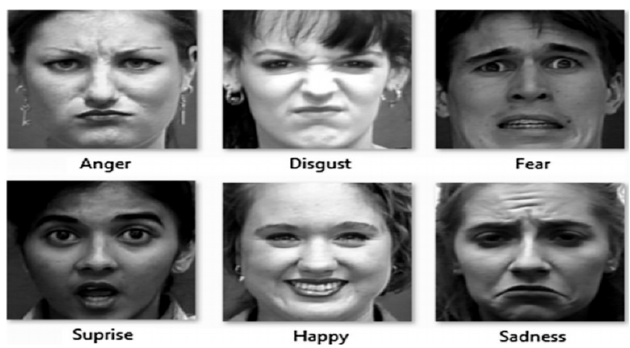
Figure 3. Six real basic facial expressions (collection three) [48].